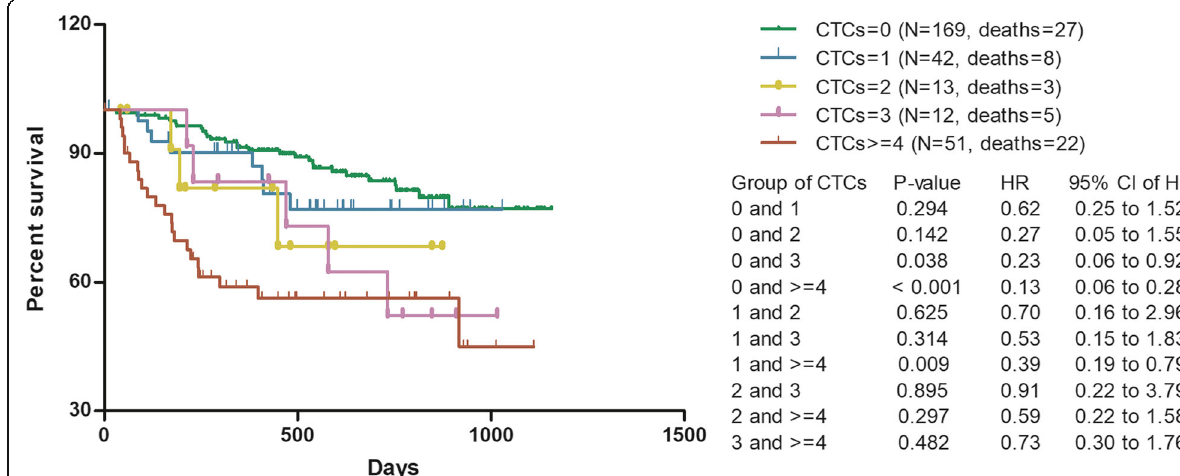
Fig. 3 Survival of advanced NPC grouped by CTCs count